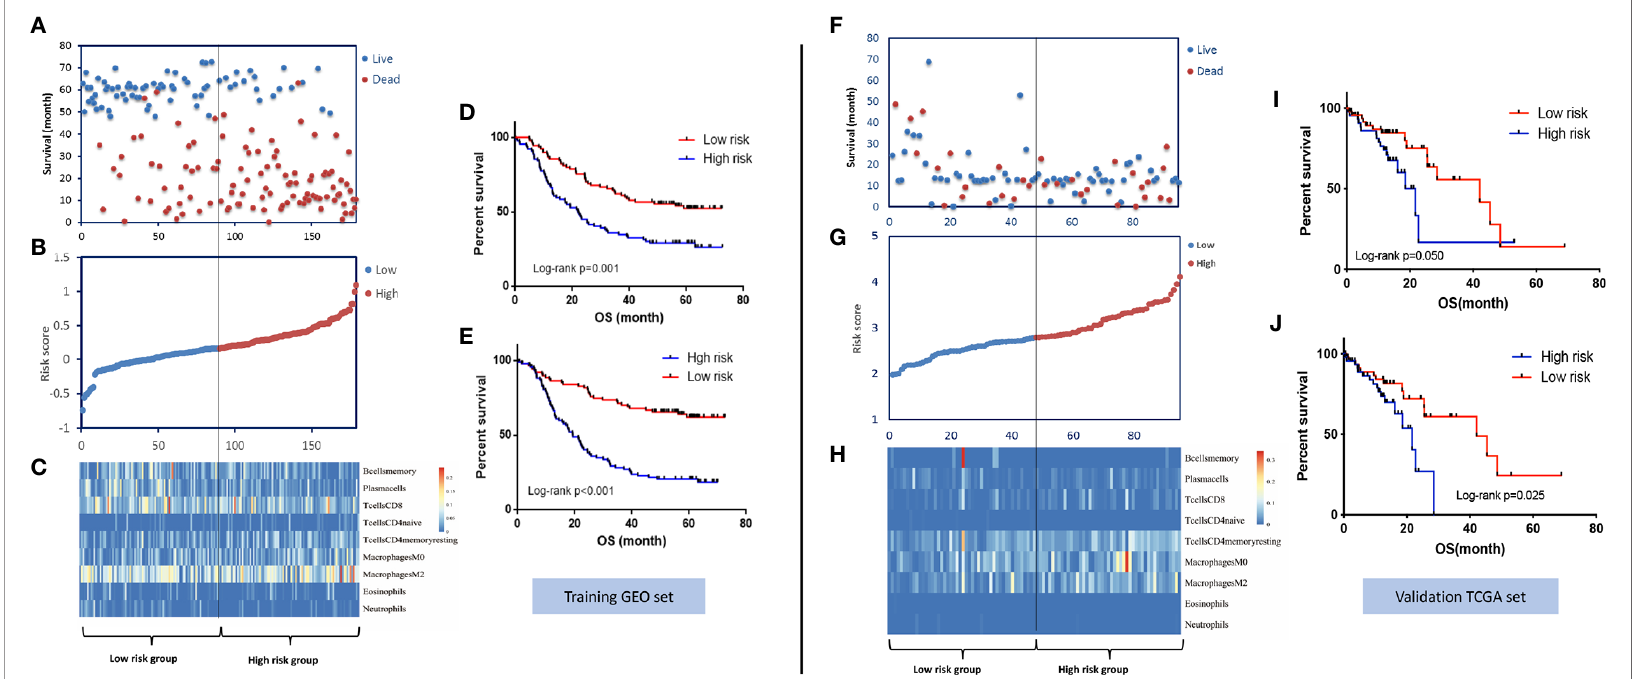
FIGURE 2 | Distribution of risk strati fi cation based on the IPS model and the survival prediction performance of the IPS in the GEO training set and TCGA validation set. (A) The distribution of survival status and survival time, (B) ranked IPS scores, and (C) heatmap of the abundances of the nine immune cell types involved in the IPS model in the GEO training set. Kaplan-Meier survival curves of patients with low- and high- risk scores using the IPS model (D) and IPS-TNM model (E) in the GEO training set. (F – J) Corresponding fi gures for the TCGA validation